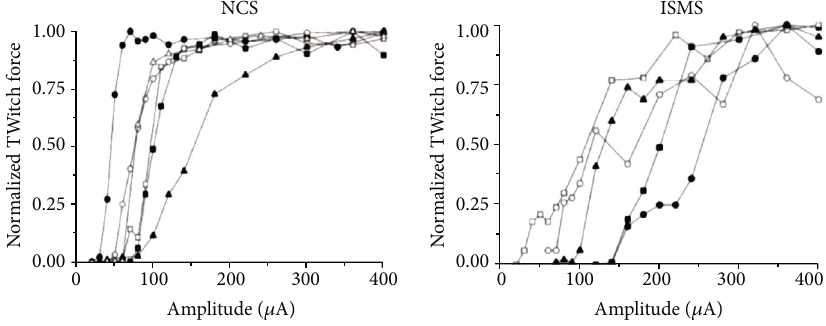
Figure 4: Muscle force changes after ISMS and Figure 5, after implantation of ISMS micro fi laments, the cat was placed in a safety belt and suspended on a treadmill. A microaccelerometer was placed on the legs of the cat to pro- vide a simulated sensory feedback signal. The spinal cord of the cat was stimulated to produce a gait like pattern [75].